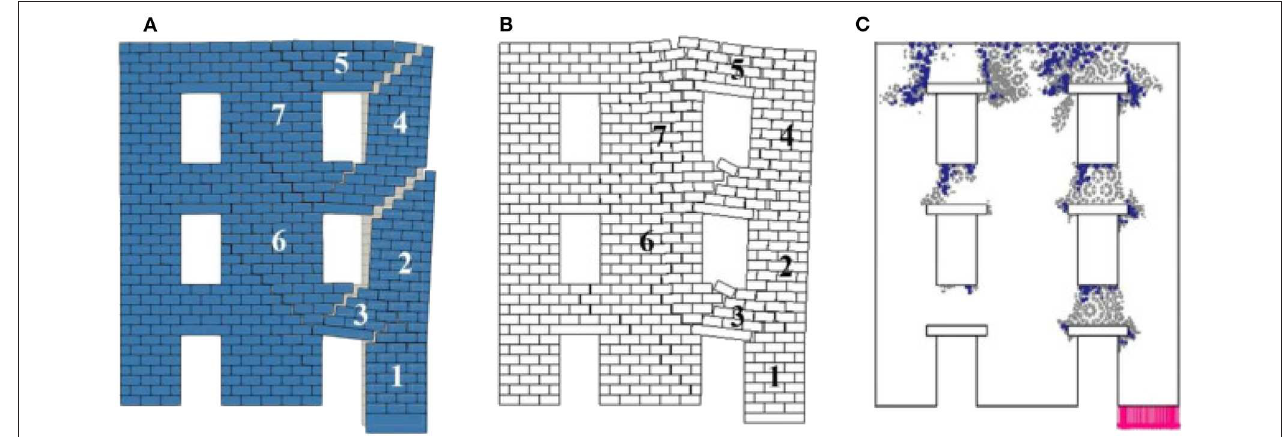
FIGURE 15 | (A) LA, (B) FEM/DEM, and (C) FEM results for Façade 3 case.